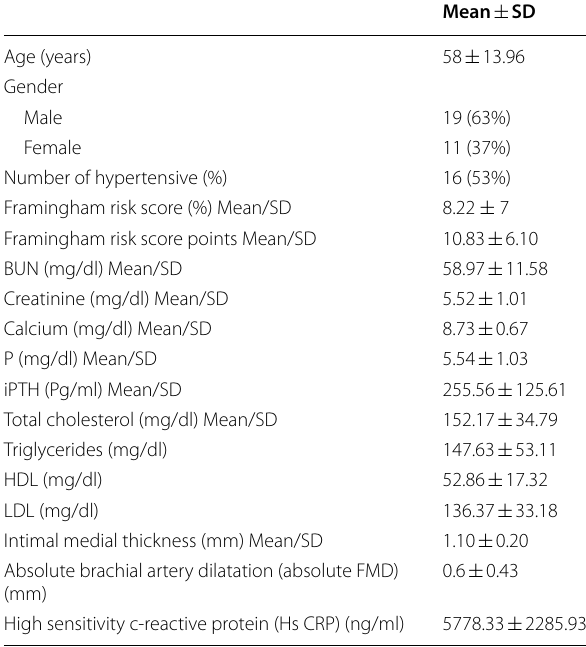
Table 1 Demography and laboratory data of the study